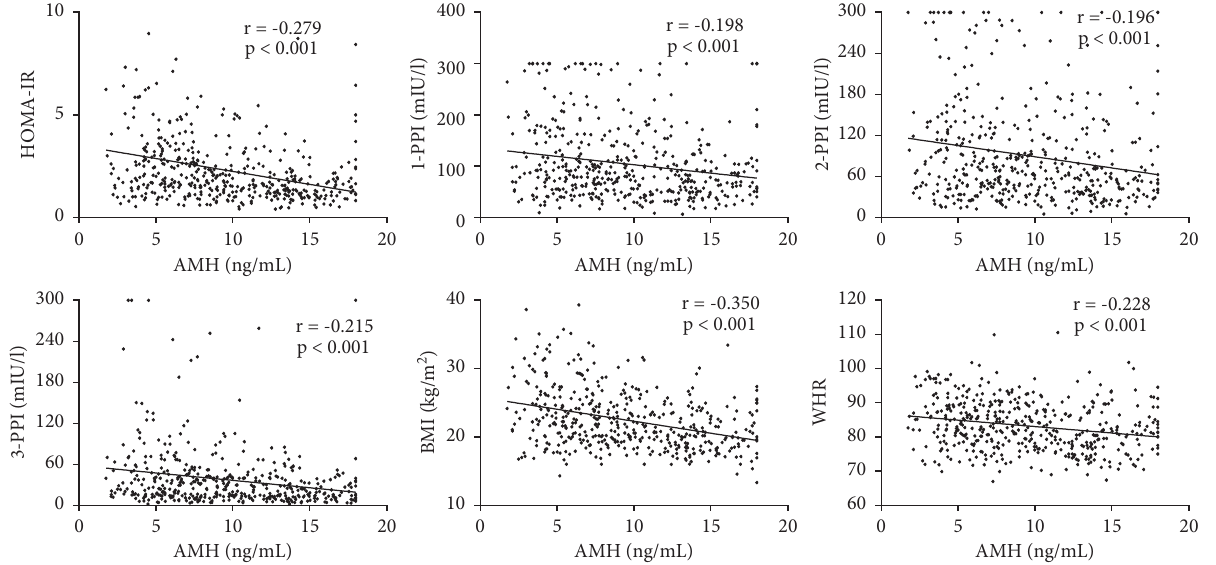
Figure 1: Relationship between AMH and metabolic parameters in women with PCOS.